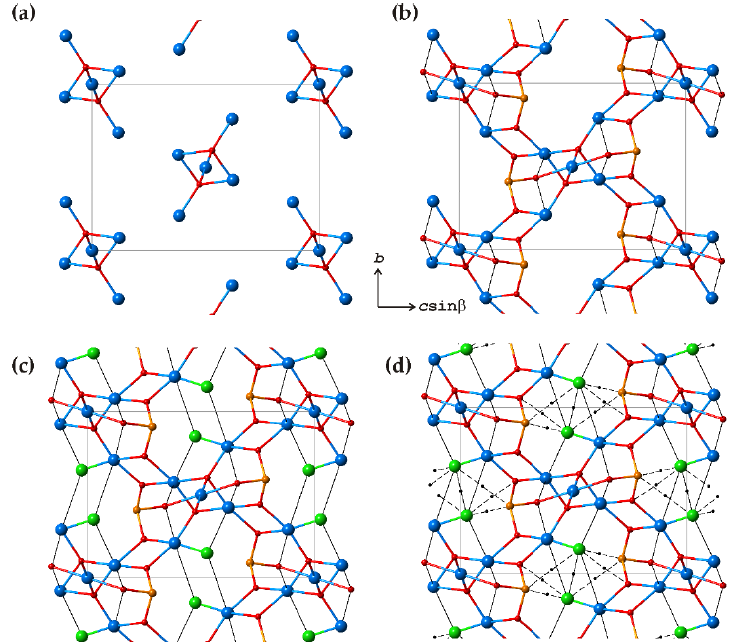
Figure 6. The scheme of successive (step-by-step) construction of the crystal structure of parageorgbokiite, β -Cu 5 O 2 (SeO 3 ) 2 Cl 2 : ( a ) the arrangement of the [O 2 Cu 5 ] chains of edge- and corner-sharing (OCu 4 ) tetrahedra; ( b ) the metal-oxide bonding network of the Cu–O and Se–O bonds; ( c ) the structure projection showing the positions of the Cl atoms; ( d ) the location of bcps corresponding to weak closed-shell interactions. See text for details. Legend as in Figure 5.